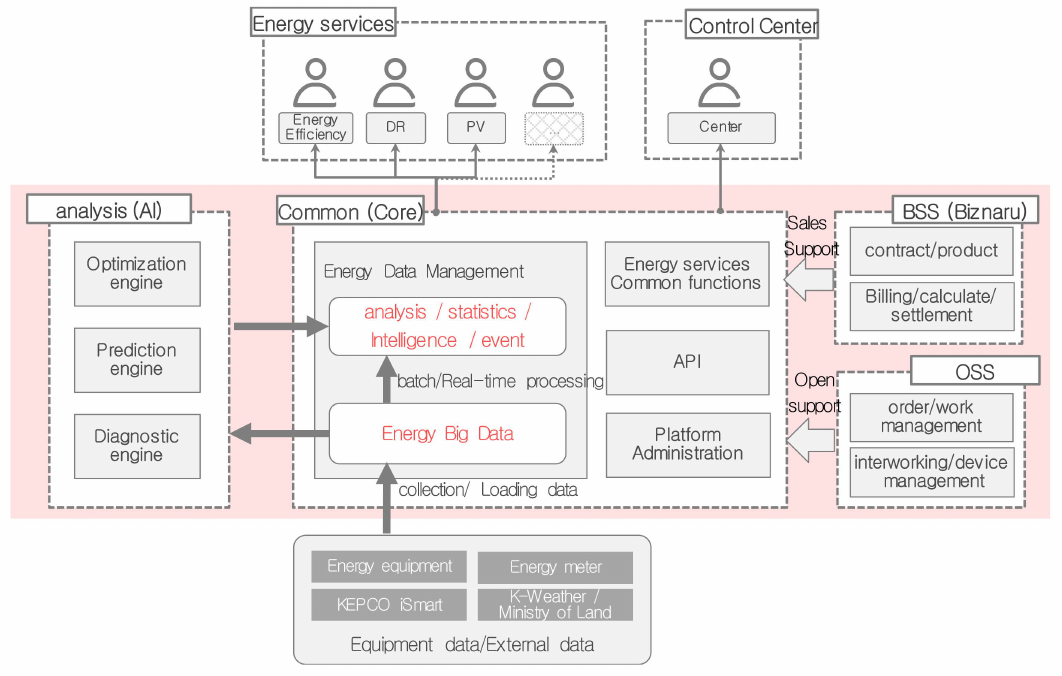
Figure 2. Schematic flow diagram of open micro energy grid platform. optimization, prediction, and